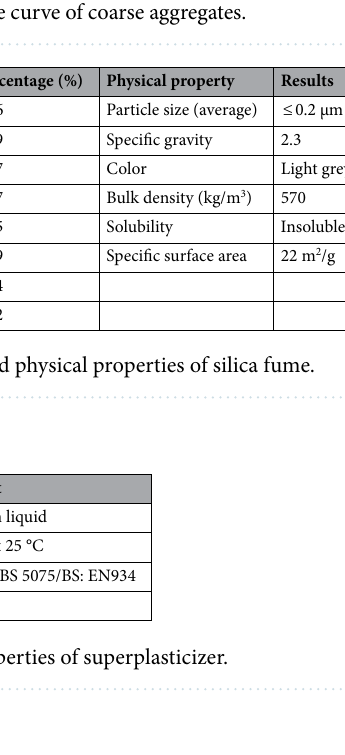
Figure 2. Grading size curve of coarse aggregates.